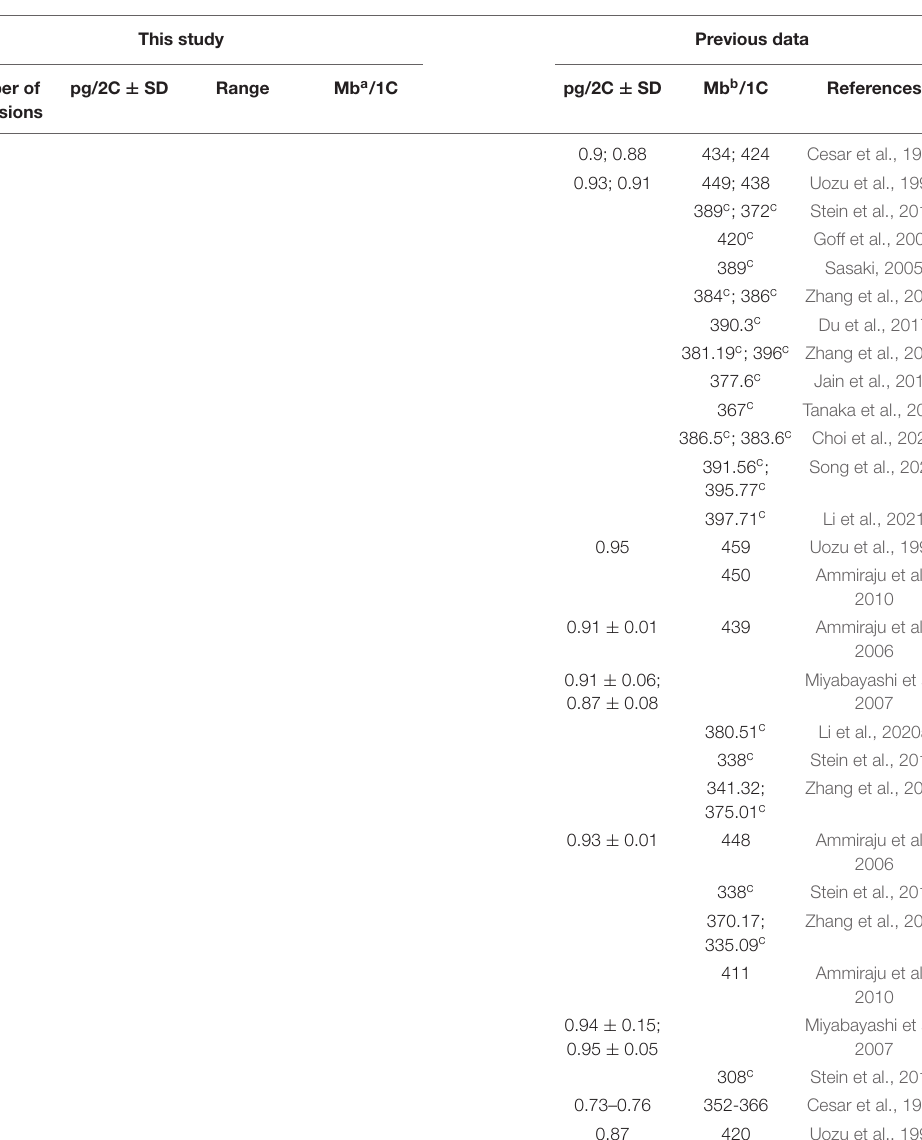
TABLE 1 | Summary of nuclear DNA contents of Oryza species estimated by using flow cytometry analysis. Species Genome